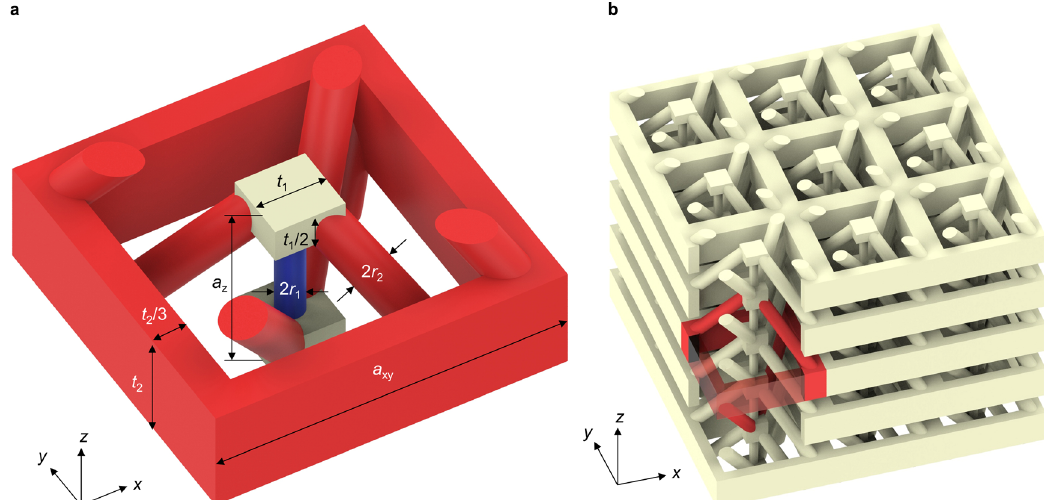
Fig. 3 Designed three-dimensional elastic metamaterial structure. a The architecture incorporates nearest-neighbor as well as beyond-nearest-neighbor interactions (cf. Fig. 2a) and is composed of a single ordinary linearly elastic constituent material. The colors are for illustration only. Elements mediating the elastic interaction between one layer and its third-nearest-neighbor along the z -direction are highlighted in red. The blue and red cylindrical rods have a radius of r 1 = a z ¼ 0 : 08 and r 2 = a z ¼ 0 : 12, respectively. The structure has no center of inversion but two mirror planes and a rotation-re fl ection symmetry, making it achiral and leading to a degeneracy of the lowest two transverse acoustical bands (cf. Fig. 4). The period of the structure along the z -direction is a fi rst Brillouin zone edges lye at wavenumbers k ¼ ± π = a x - and y -directions is z , the corresponding z z (cf. Fig. 4). The period or lattice constant along the a ¼ 2 a t = a ¼ 0 : 40, t = a ¼ 0 : 60, and a ¼ 100 μ m. b 3 ´ 3 ´ 5 unit cells out of a corresponding bulk xy z . The other geometrical parameters are z z z 1 2 metamaterial, with the front corner cut out to allow for a view inside. The part highlighted in red illustrates the beyond-nearest-neighbor interaction. Two red rods connect a fi rst cube to the red frame (made partly transparent at the corner). Two further red rods connect this frame to a second cube, which has a distance 3 a z with respect to the fi rst cube. An animated view of the structure is given in Supplementary Movie